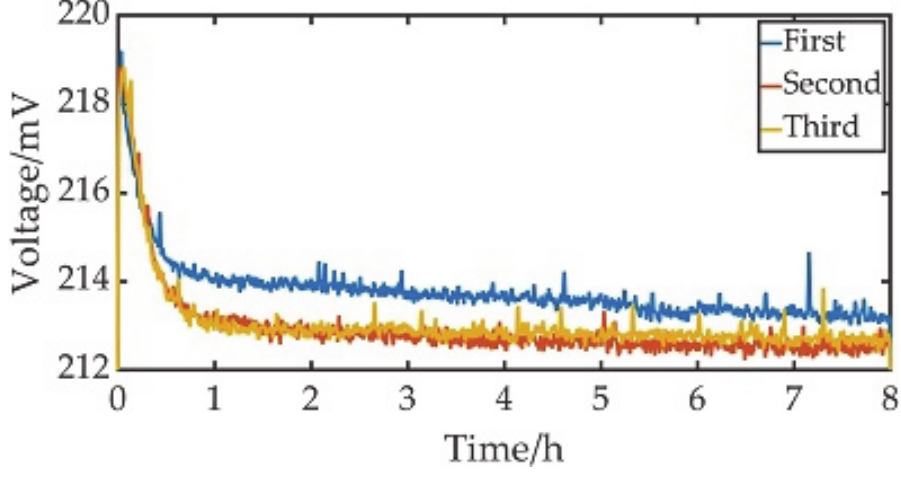
Figure 13. The output voltage of PD in Experiment 2.